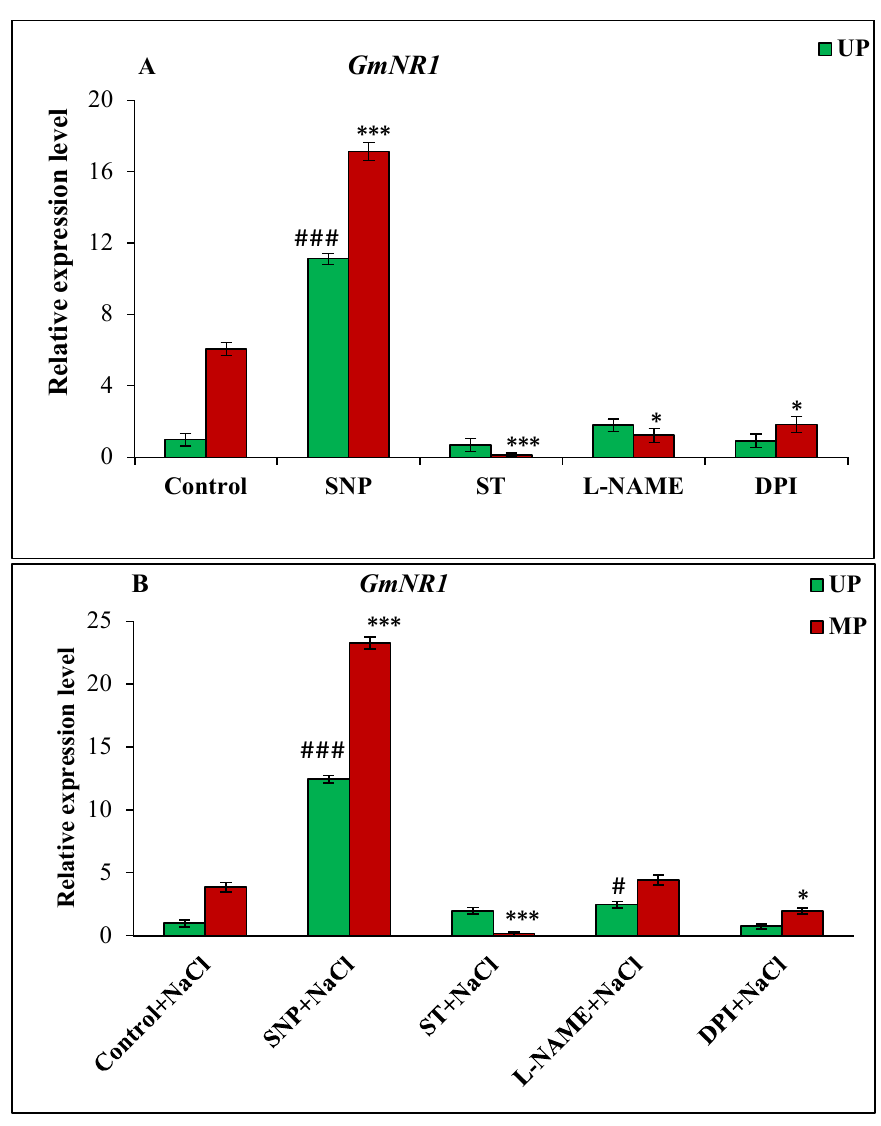
Figure 7. Relative expression analysis of GmNR1 genes in soybean seeds kept for 24 h in different modulators of NO and ROS production under non-saline ( A ) and saline ( B ) conditions. The data are represented as the means ± SE (n = 3). ### p < 0.01, # p < 0.05 indicates the significant difference amongst the UP seeds grown in control with the UP seeds grown in different modulators of NO/ROS under non-saline or saline conditions; *** p < 0.001, * p < 0.05 indicates the significant difference amongst the MP seeds grown in control with the MP seeds grown in different modulators of NO/ROS under non-saline or saline